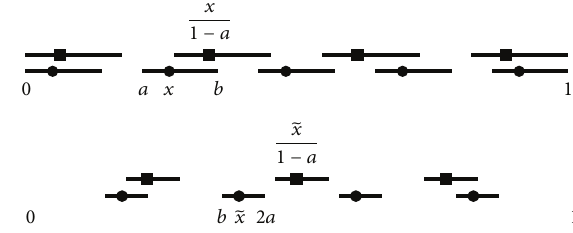
Figure 2: Scheme of summation intervals placement for (7) (upper) and (8) (lower), here 𝑏 = 1 − (𝑛 − 1)𝑎 , even 𝑛 .